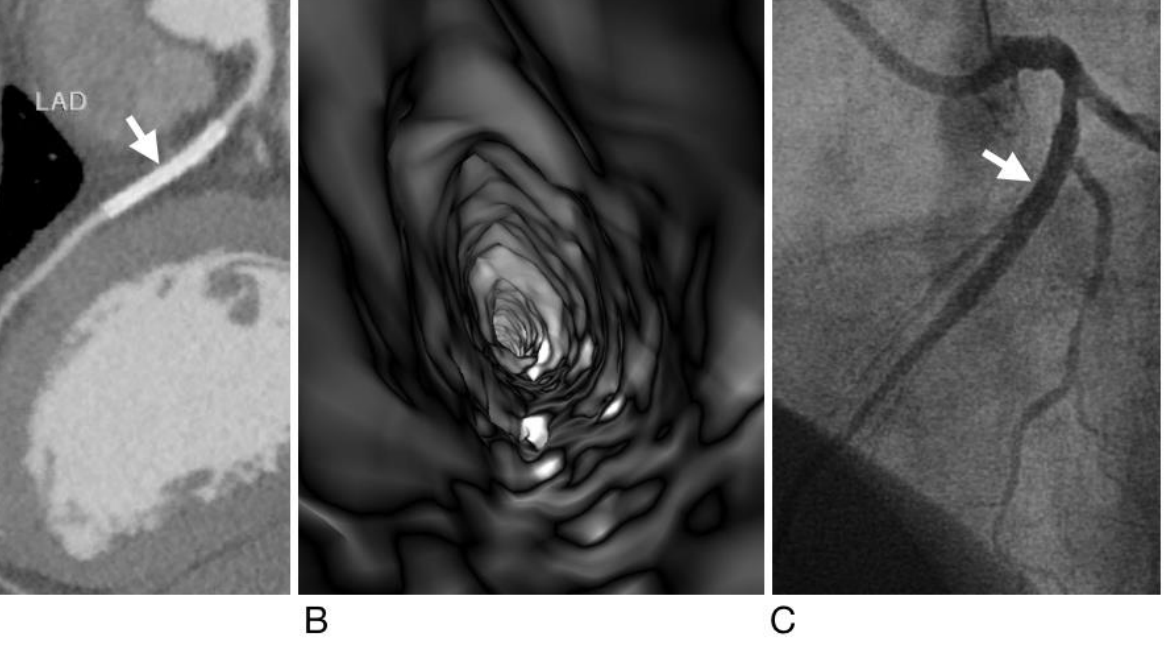
. Figure 3. A case of true positive result for both CCTA and VIE. Subject is a 57-year-old man with hypertension and obesity (body mass index = 30.7 kg/m 2 ) and with a total calcium score of 1125. A metallic stent was placed in the left circumflex artery. Both CCTA ( A ) and VIE ( B ) showed ISR at the distal edge of the stent (arrow). This was confirmed by ICA ( C ), showing 88% stenosis (arrow).